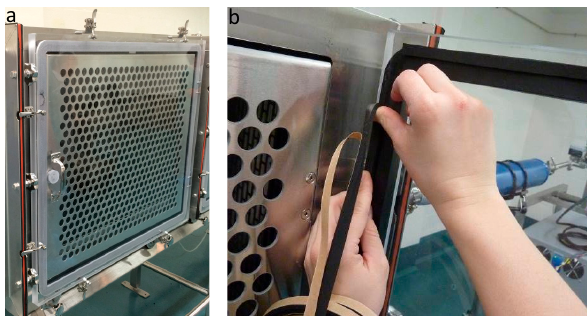
Figure 3. Cage door components. ( a ) Perforated stainless steel door and transparent polycarbonate door. ( b ) Rubber seal of the polycarbonate door.